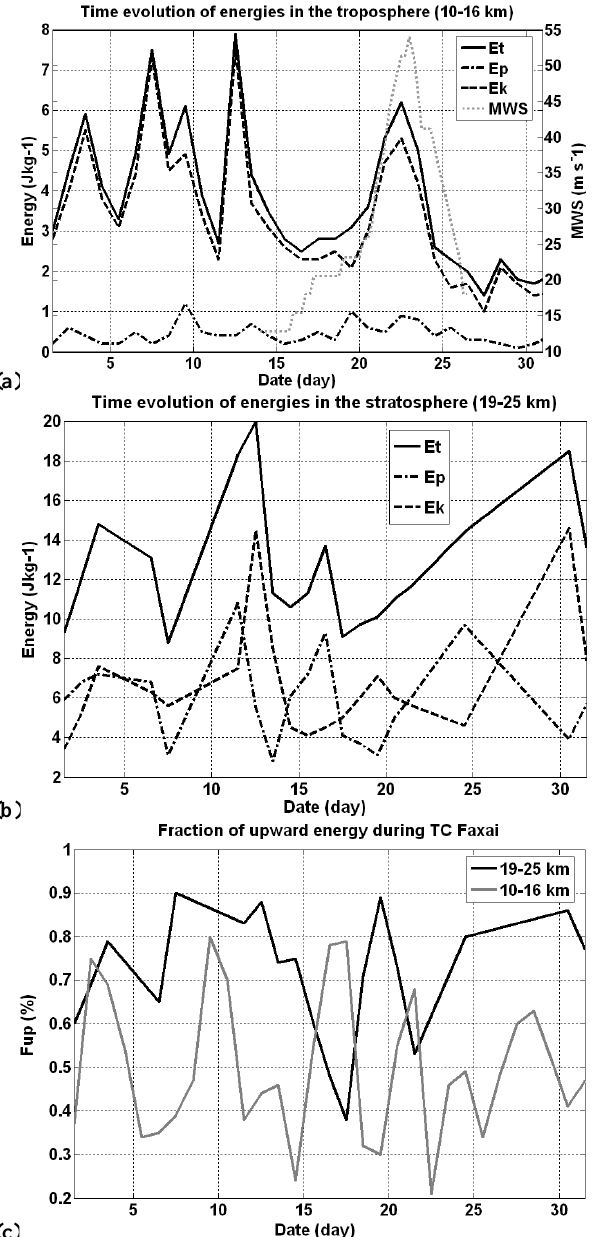
Fig. 11. (a) Hovm¨oller diagram (time versus longitude) of 2.5 ◦ – 2.5 ◦ gridded NOAA Interpolated MJO filtered OLR data aver- aged over latitudes between 0 ◦ N and 20 ◦ N for longitudes between 100 ◦ E and 177.5 ◦ E and from 1 December 2001 to 31 January 2002, (b) Period-longitude distribution of Fast Fourier Transform spectral density in base-10 logarithmic scale and (c) Period-time diagram of modulous of continuous complex Morlet transform co- efficients (5 octaves and 30 voices). OLR data is filtered by using a fourth-order polynomial